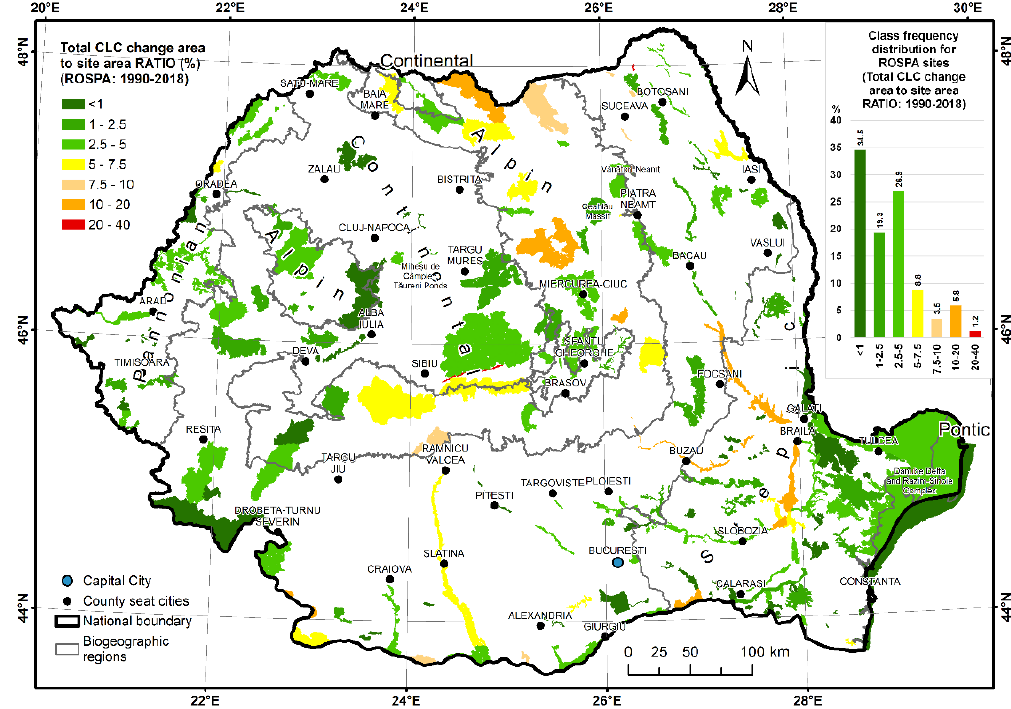
Figure 2. Changed area-to-site area ratio (%) for ROSPA-Romanian Special Protected Areas (1990– 2018).